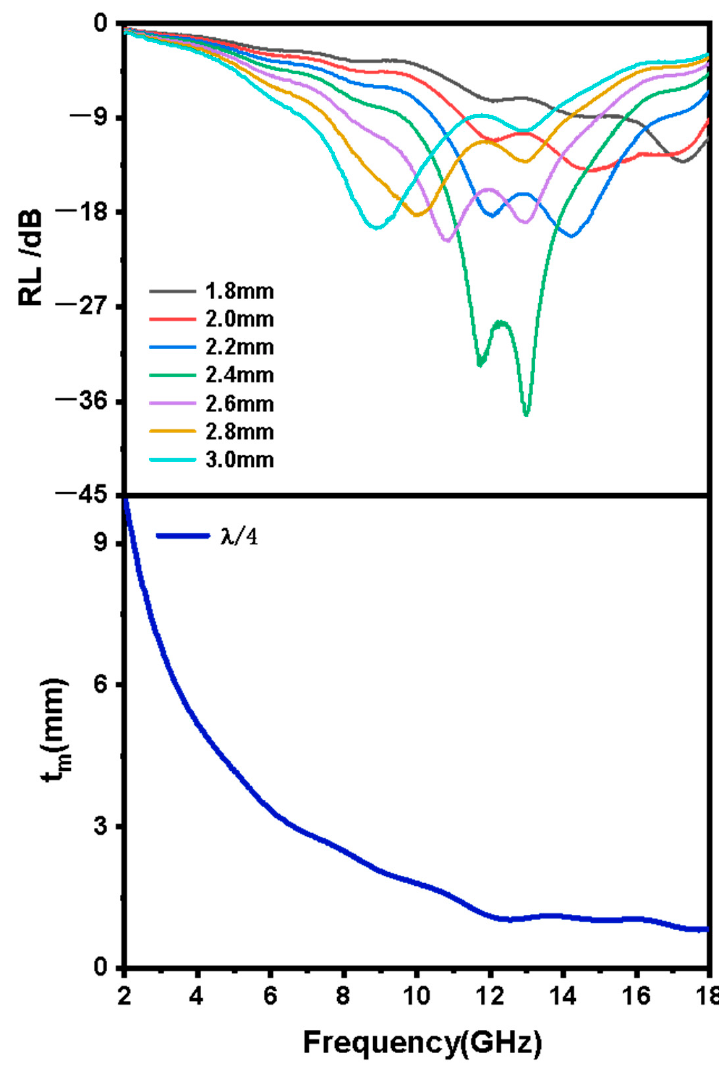
Figure 12. Comparison of various absorbent thicknesses (t m ) at the frequency for FeNi 3 alloys with 70 wt% mass ratio sample in λ /4 conditions of maximum RL values (f m ).